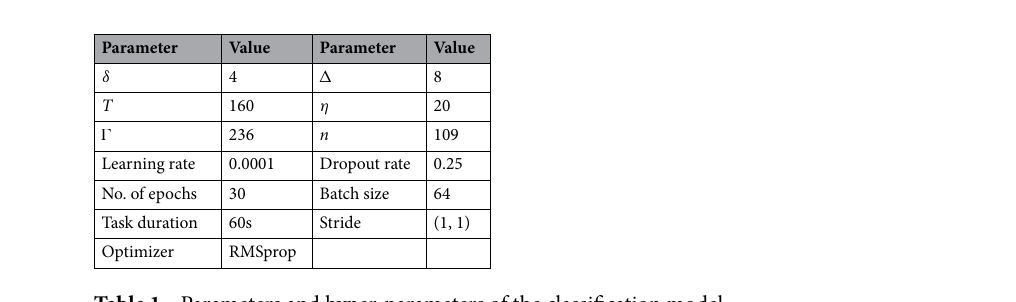
Table 1. Parameters and hyper-parameters of the classification model.